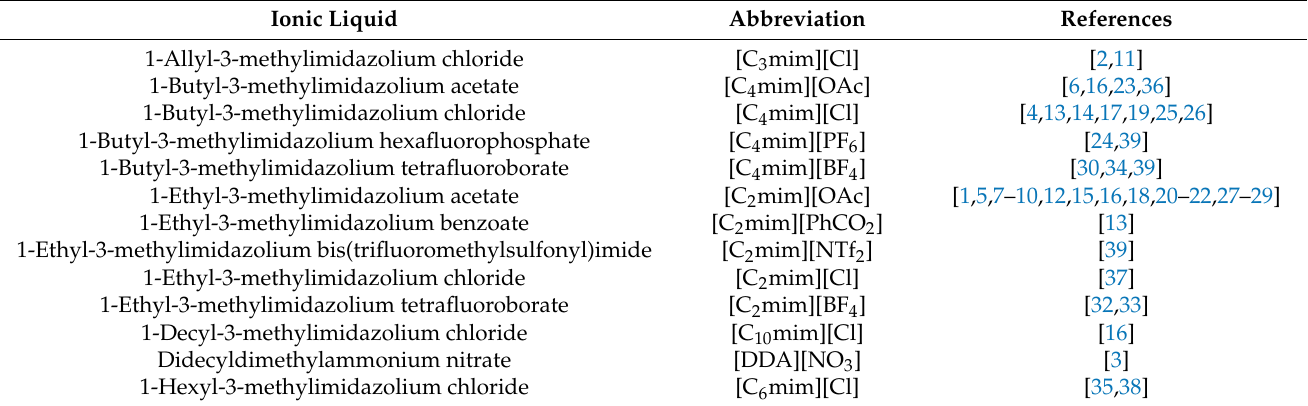
Table 2. Examples of ionic liquids utilized in the electrospinning of biodegradable polymers.